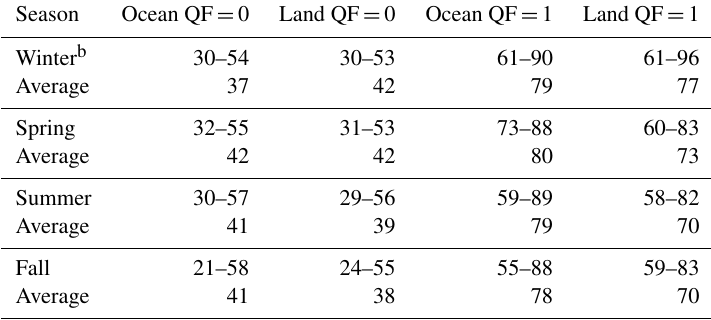
Table 2. The fractions of OCO-2 lite file observations (in percent) that have a cloud within 4km of an observation footprint for each season a .